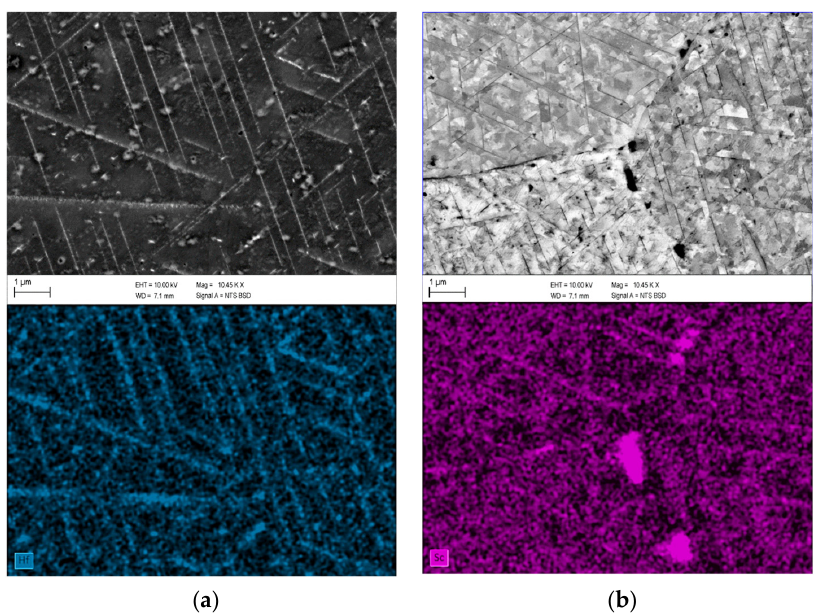
Figure A4. Lamellar distribution of enhanced scandium and hafnium content, analyzed with EDS: ( a ) CuHf0.7 without cold rolling, prior 48 h of isothermal aging at 500 °C; ( b ) CuSc0.3 without cold rolling, prior 48 h of isothermal aging at 450 °C.